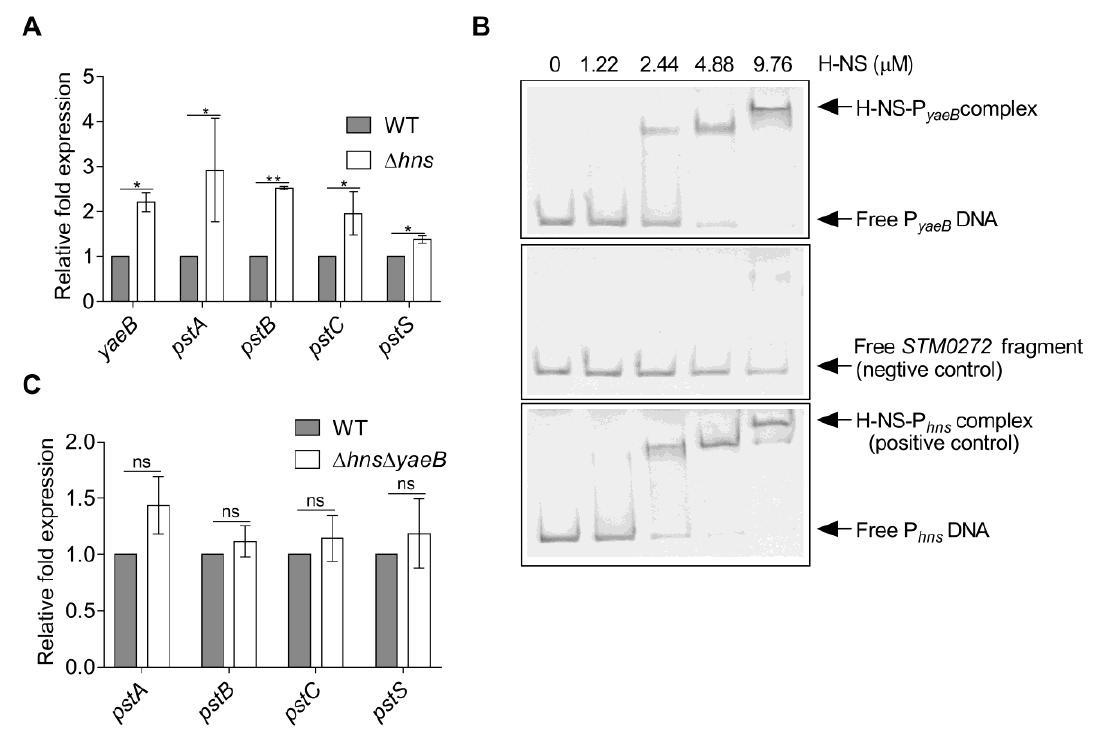
Figure 4. H-NS directly repressed yaeB gene expression. ( A ) Gene expression levels of yaeB , pstA , pstB , pstC , and pstS in WT and hns mutant strains were assessed by qRT-PCR. Relative fold changes in gene transcription in the hns mutant relative to their expression in the WT strain are presente d.